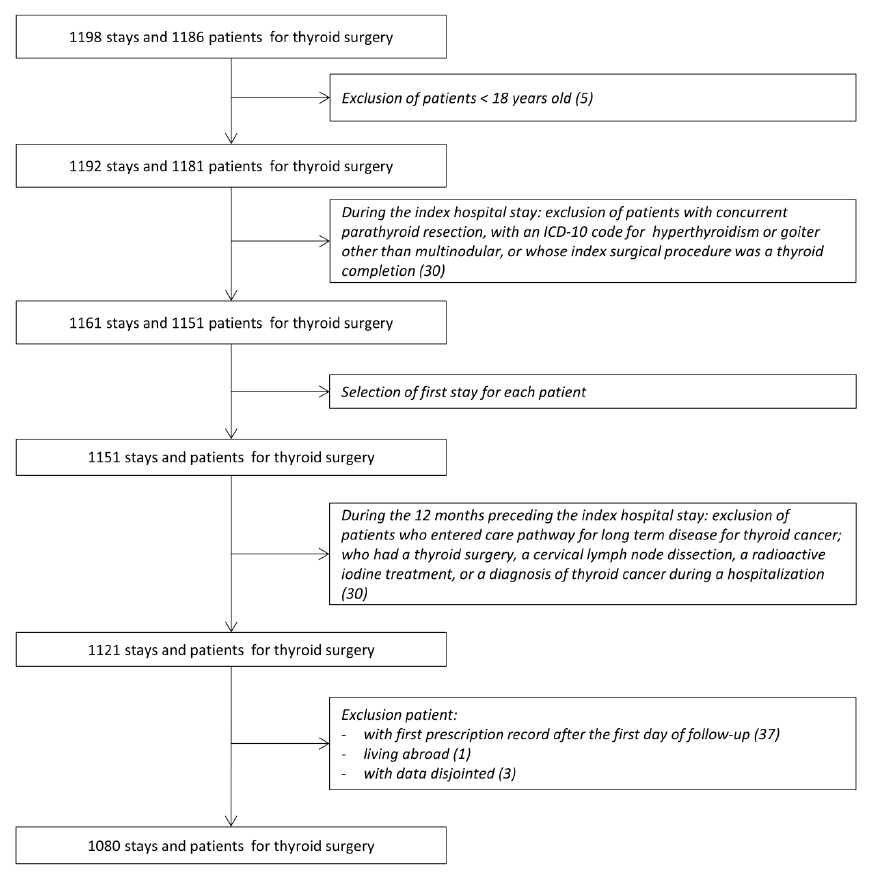
Figure 1. Flow Figure 1. Flow chart.